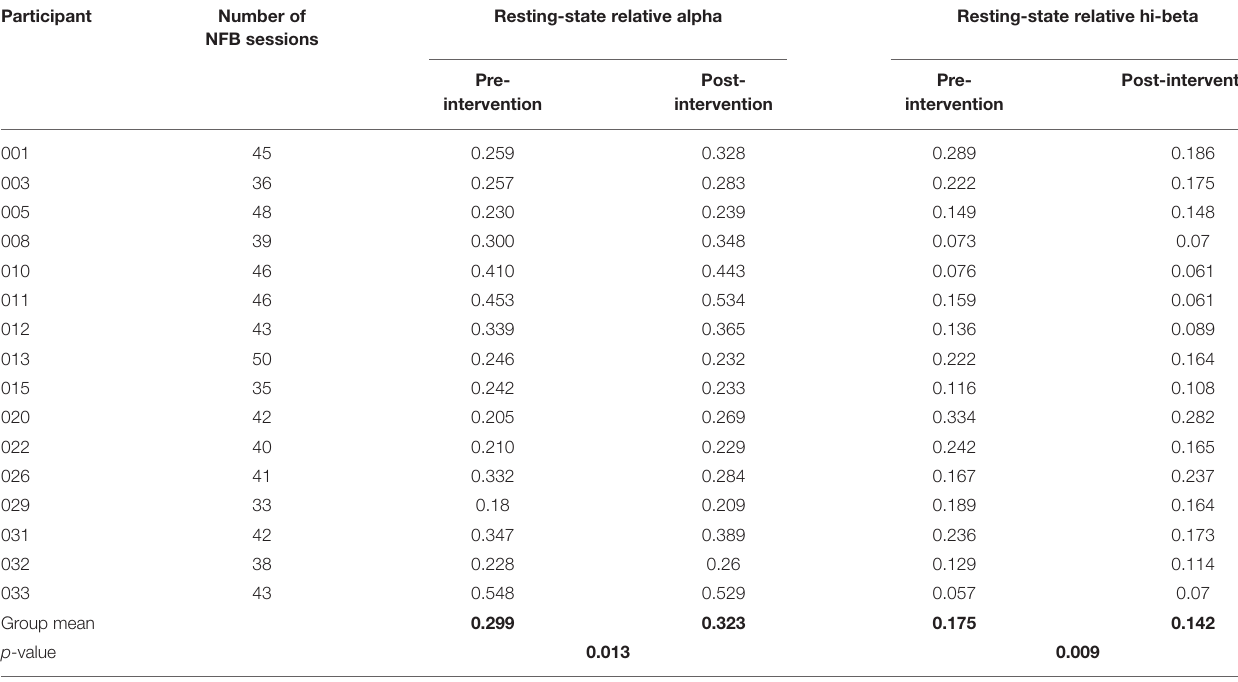
TABLE 5 | Relative alpha and hi-beta self-regulation over intervention, as shown by pre- and post-intervention activity.